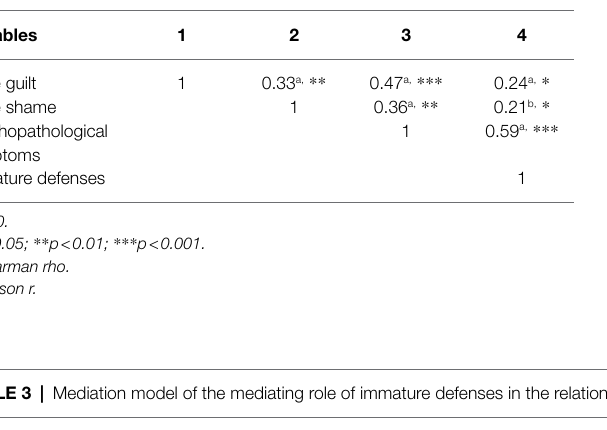
TABLE 2 | Correlation between study variables.